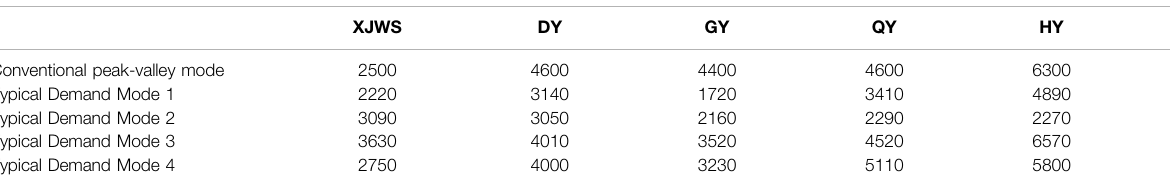
TABLE 1 | Typical demand modes after K-means clustering (Unit:MW).